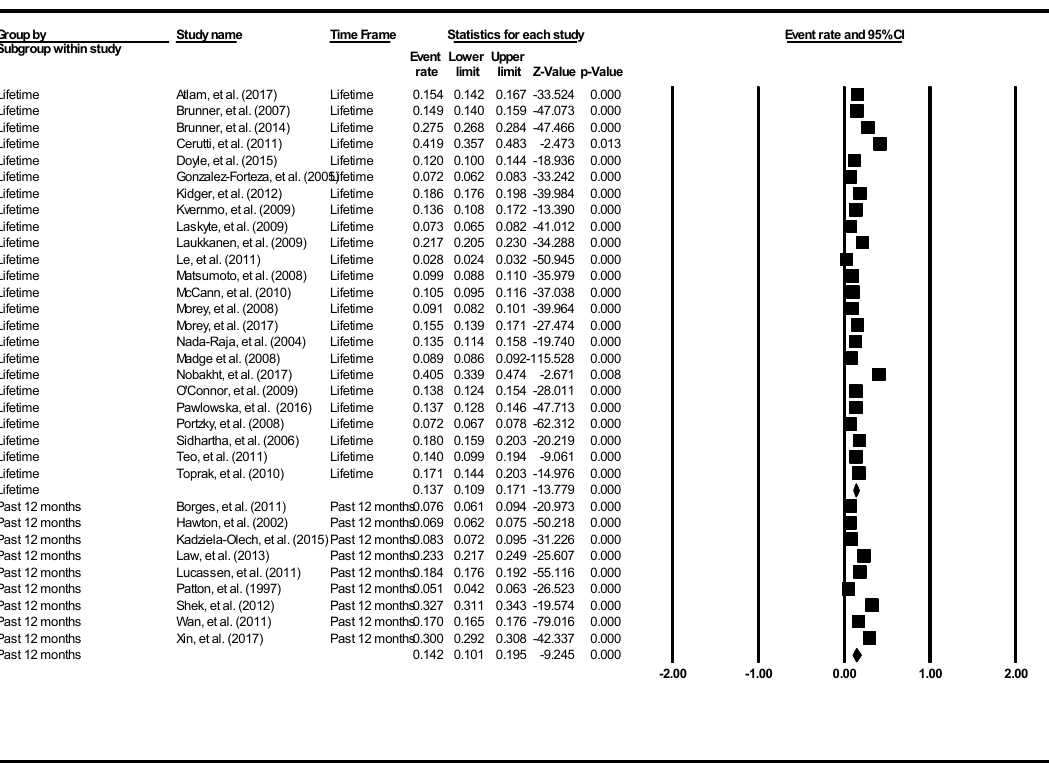
Figure 8. Forest plot of the aggregate lifetime and 12-month prevalence of deliberate self-harm.